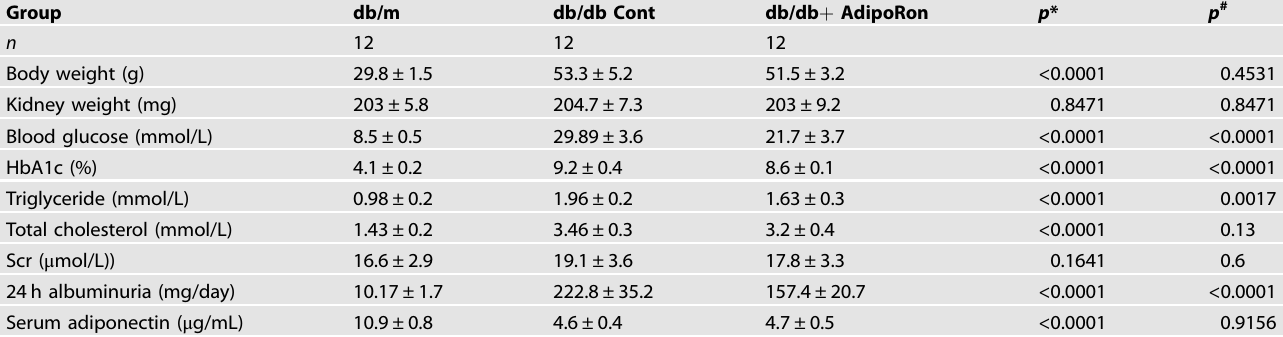
Table 2. Characteristics of the different groups ’